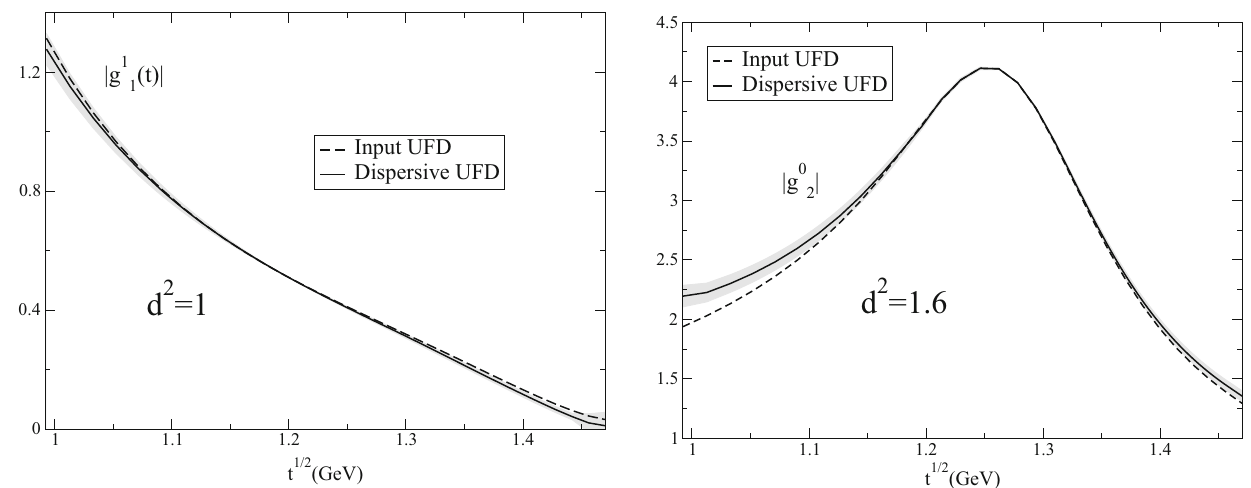
Fig. 5 Comparison between the input (dashed line) and the dispersive output (continuous line) for the modulus of the g 1 in Eq. (46). The gray band covers the uncertainty of the difference